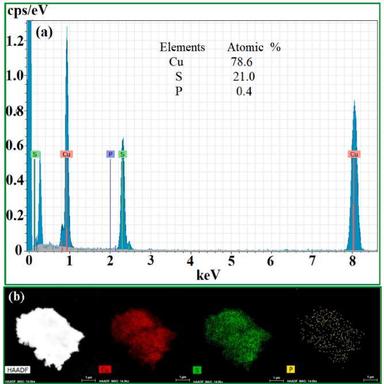
EDX spectra (a) and corresponding elemental mappings (b) for Cu, S and P of CuSP.